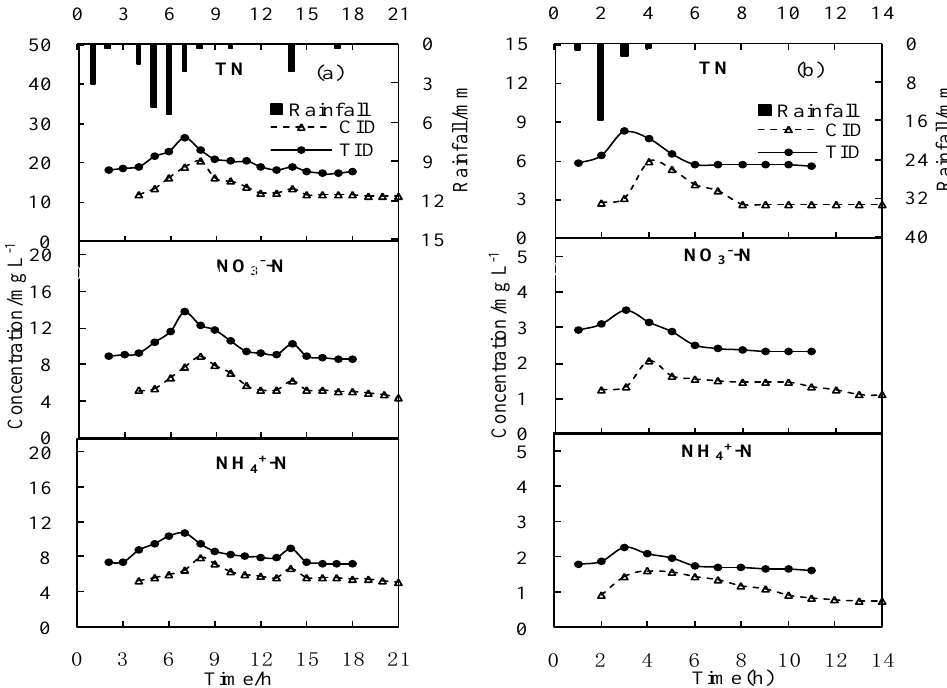
Figure 3. Nitrogen loss during the individual rainfall events on 21 July ( a ) and 25 August ( b ). The peak value of nitrogen concentration occurred at the initial stage of rainfall.